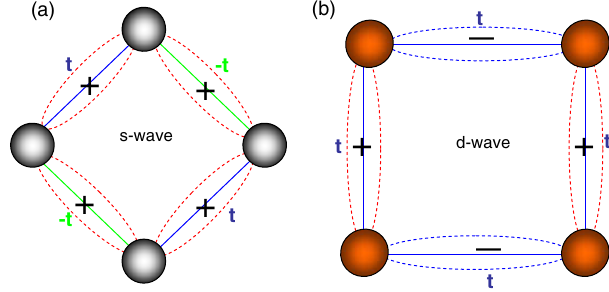
FIG. 8. A sketch of the correlation between the hopping and pairing symmetries for both iron-based superconductors and cuprates. The black (a) and the bronze (b) balls represent Fe and Cu atoms, respectively. The blue and green solid lines indicate that the hoppings between two connected atoms have opposite signs. The red and blue dashed lines indicate that the SC pairings between FIG. 7. (a) An illustration of a single Fe-As(Se) layer and the two connected atoms have opposite setup for a dc SQUIDS measurement to measure the sign change of the SC phase between top and bottom As(Se) layers. (b) The s -wave state in the phase distribution in the A phase of the A 1 g view of a d -wave picture (red for one isospin component and blue for the other). (c) The phase distribution in the B phase of s -wave state. the A 1 g